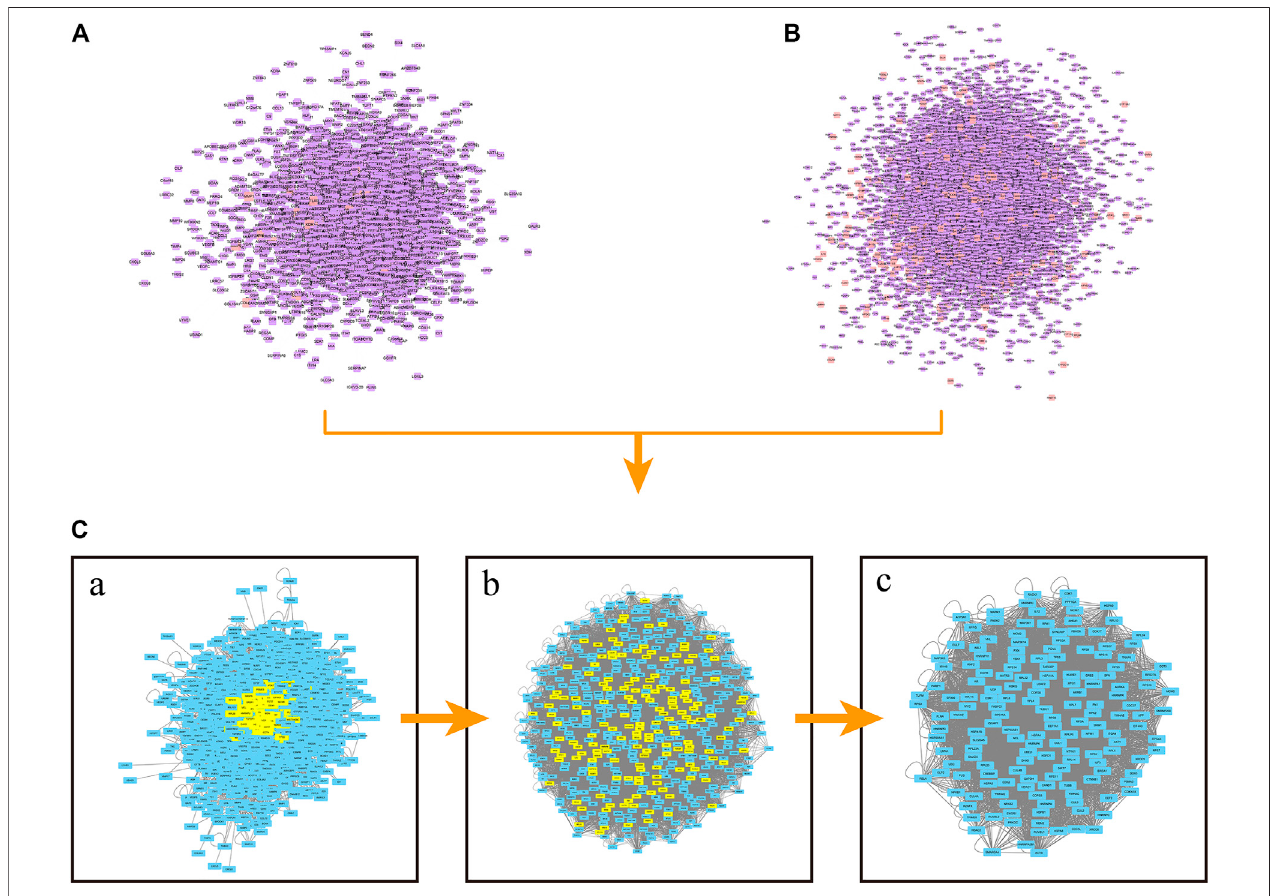
FIGURE 2 | PPI network construction. (A) PPI network of celastrol. Orange square nodes represent the celastrol targets. Purple square nodes represent proteins interactingwithcelastrol targets. (B) PPInetworkofovarian cancer.Orangesquarenodesrepresenttheovarian cancertargets. Purplesquare nodesrepresentproteins interacting with ovarian cancer targets. [C(a)] Merged PPI network. [C(b)] PPI network fi ltered based on the parameter DC ＞ 67. [C(c)] Core PPI network.